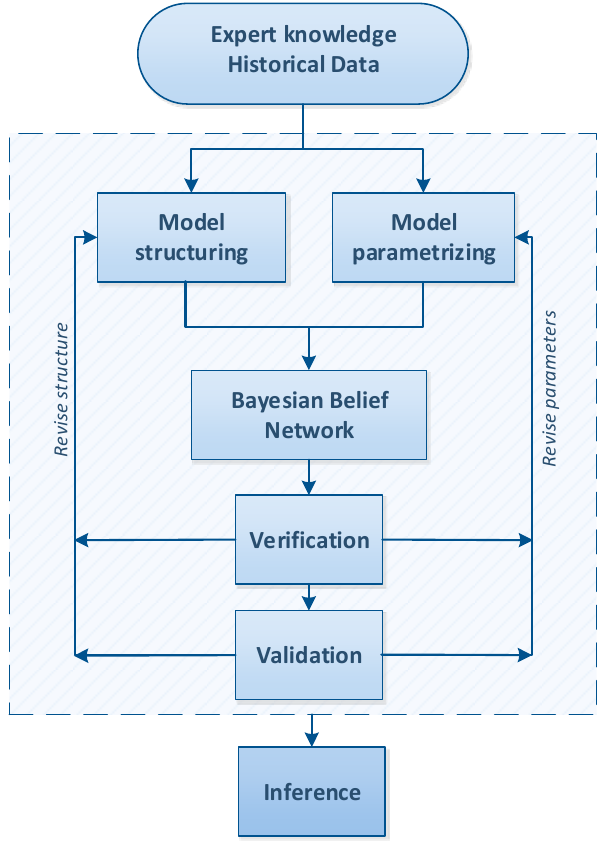
Figure 1. The BBN framework for maritime accident risk factor assessment.